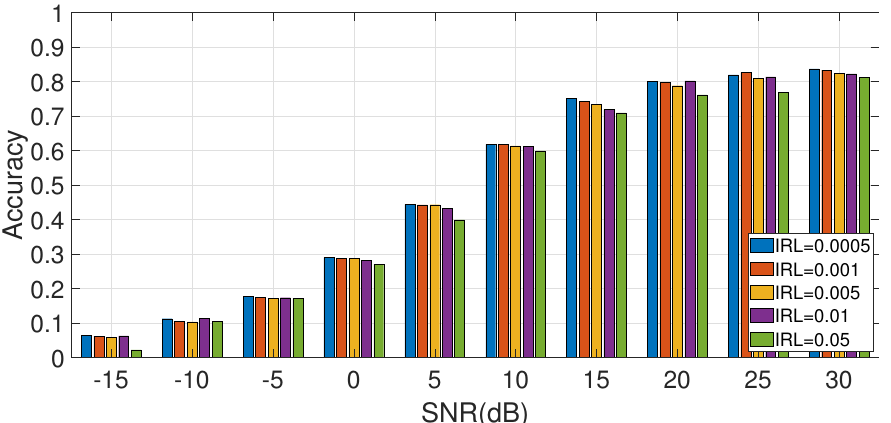
Figure 5. Accuracy trends with CNN for different values of the Initial Learning Rate (IRL) and different values of SNR in dB with Opt seg = 64.